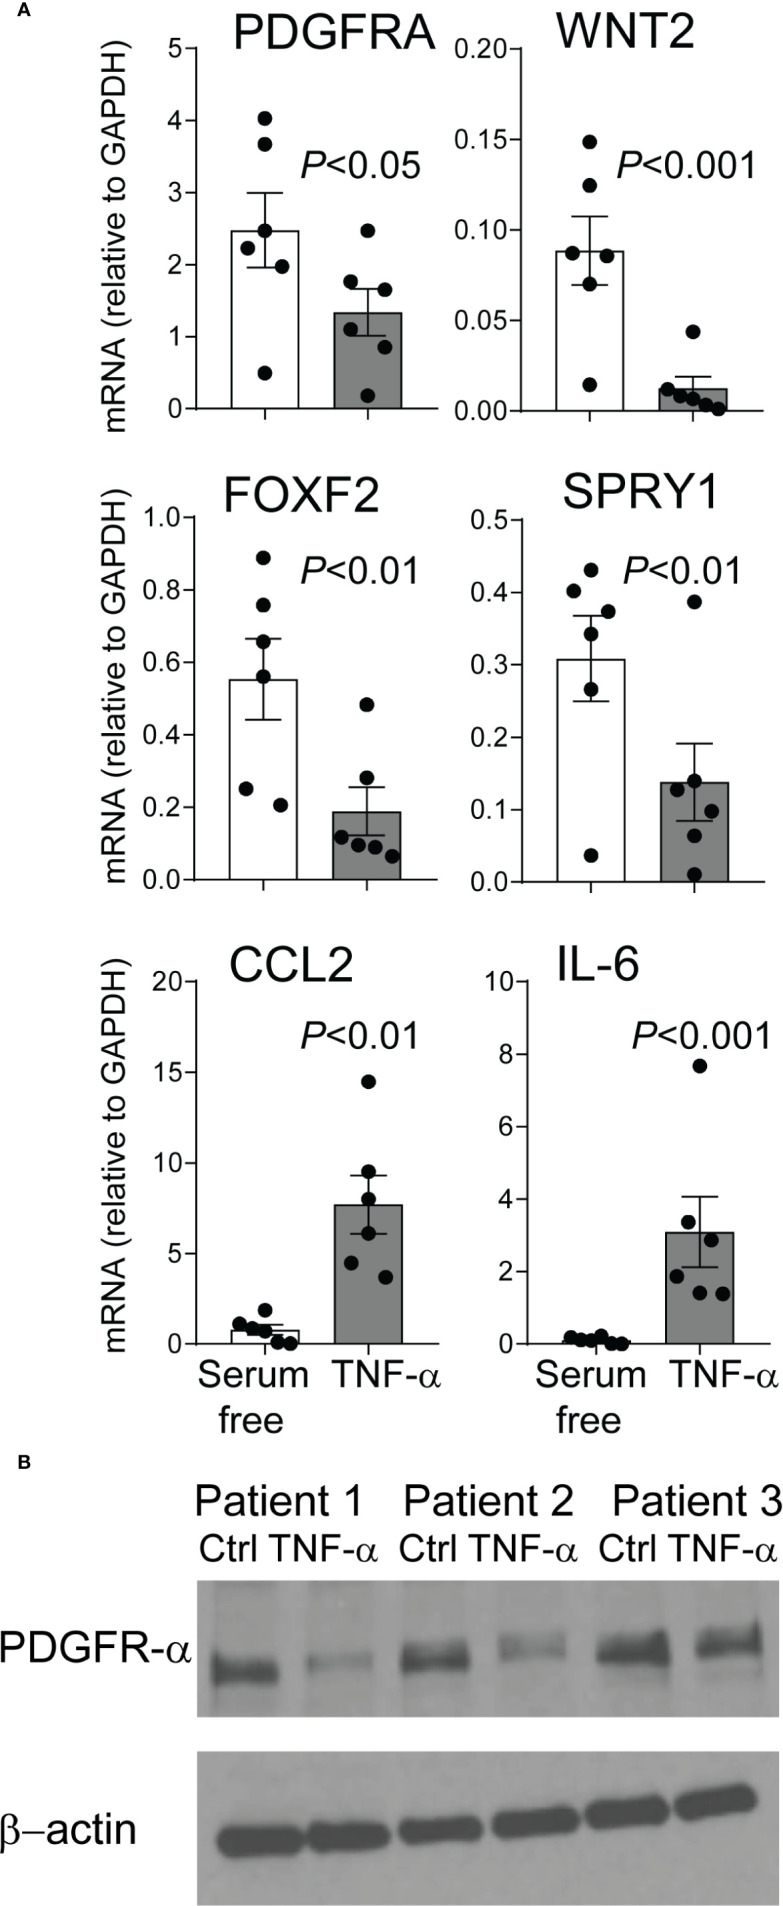
TNF-α treatment of mesenchymal stromal cells reduces PDGFR-α expression. Human preterm lung mesehncymal stromal cells (MSCs) were cultured in serum free medium with or without 5 ng/ml TNF-α for 48 h. PDGFR-α mRNA and protein expression was assessed by qPCR and ELISA, respectively. Also assessed was the mRNA expression of WNT2, FOXF2, SPRY1, CCL2, and IL-6 mRNA expression. (A) TNF-α treatment significantly reduced mRNA expression of PDGFRA, WNT2, FOXF2, and SPRY1 and increased mRNA expression of CCL2 and IL-6. N = 6, one-way ANOVA. (B) TNF-α treatment significantly reduced PDGFR-α protein expression.